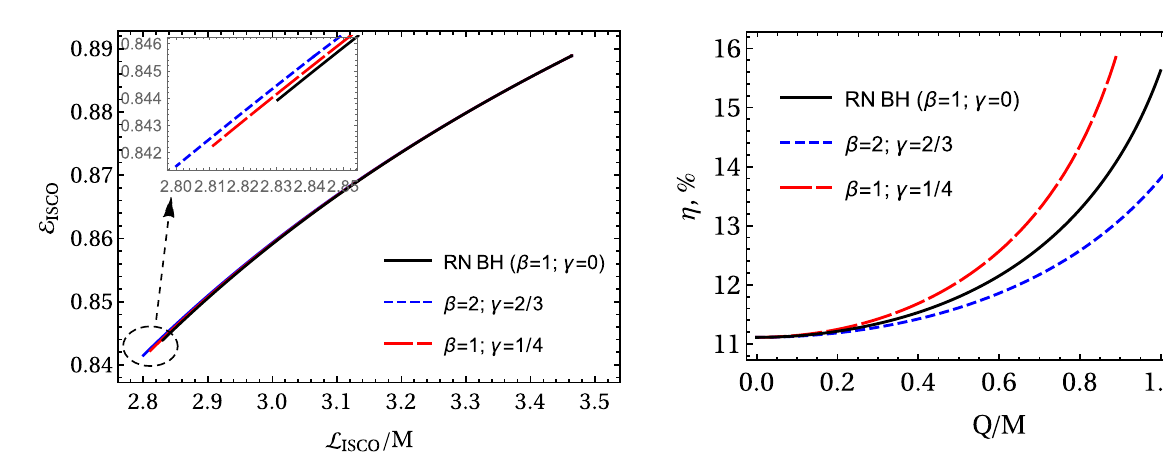
Fig. 7 Dependence of energy and angular momentum of test particles at ISCOs around EMS BHs from the ISCO radius ( E ISCO and L ISCO ) for different values of parameters β and γ at the range of the BH charge from 0 to corresponding Q extr